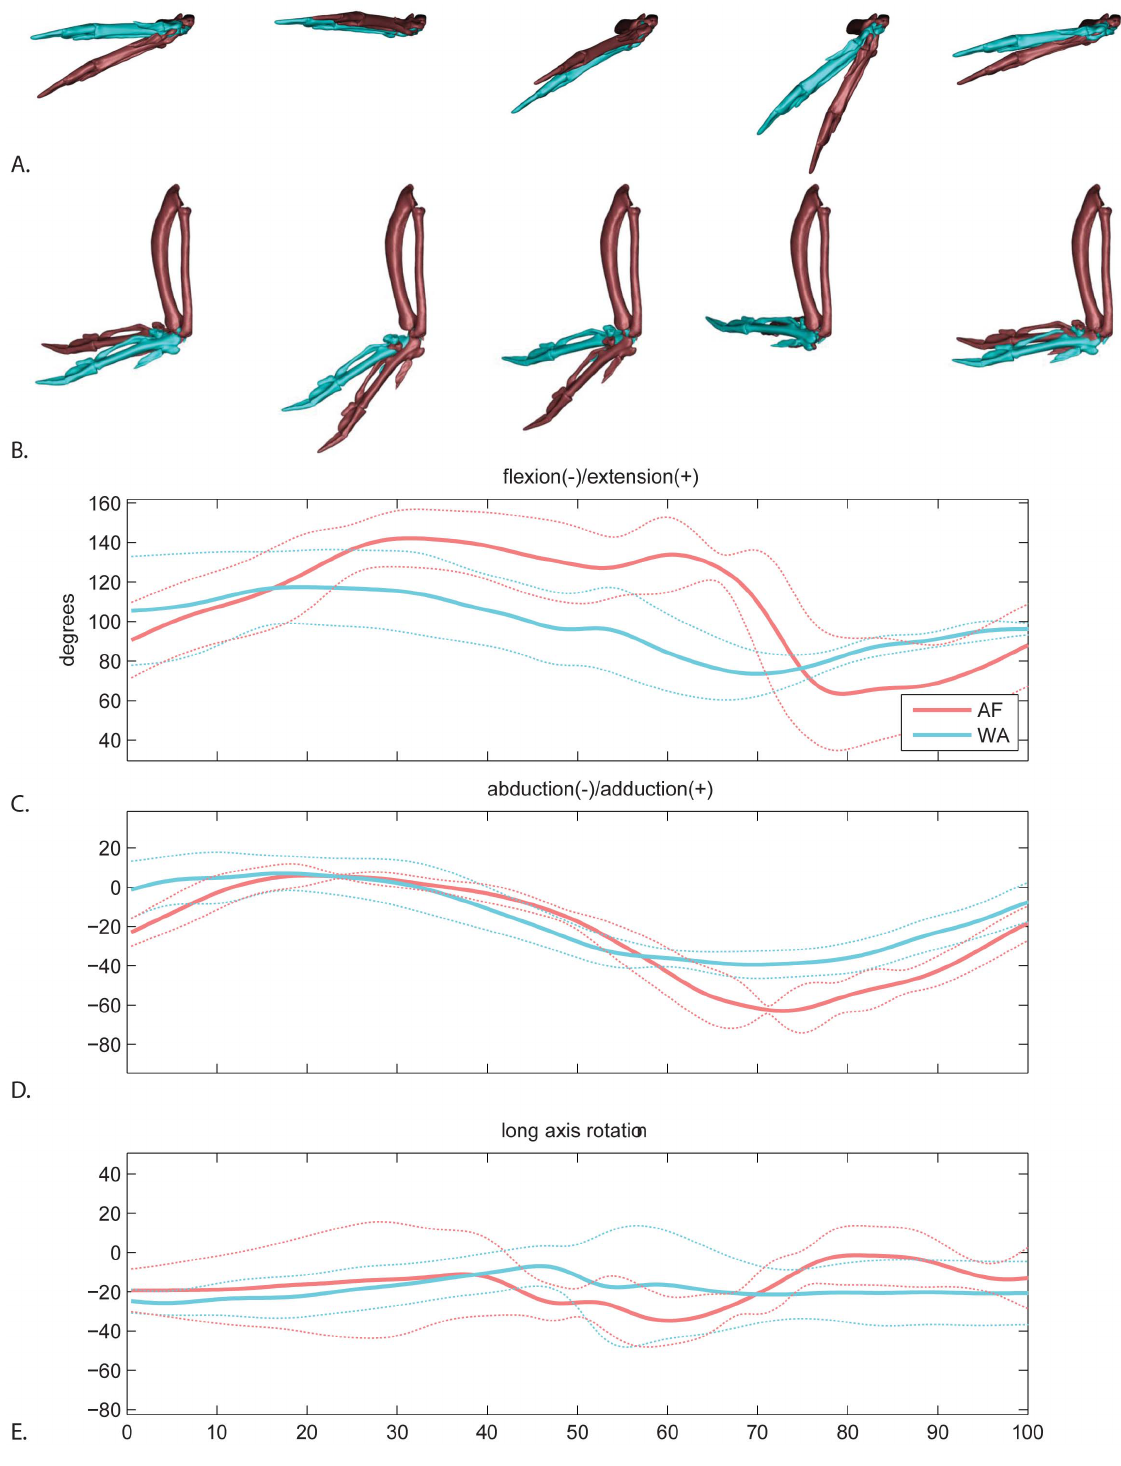
Figure 8. Wrist motion. A. lateral view and B. dorsal view (below) of the average AF (red) and WAIR (blue) wingbeats at 0, 25, 50, 75 and 100% of the cycle. Manus shown relative to a fixed antebrachium. C–E. mean and standard deviations for each rotational degree of freedom. Time scale 0 to 50%=downstroke, 50–100%=upstroke. doi:10.1371/journal.pone.0063982.g008 elbow). Abduction (angled dorsally relative to the horizontal plane 41.4 6 5.8). Both behaviors followed a similar timing pattern of of the ulna) was minor in both behaviors; the majority of being near horizontal during downstroke then gradually adducting during late downstroke. The primary difference occurred in mid- movement was adduction (Fig. 8D; AF 69.9 6 5.1; WAIR